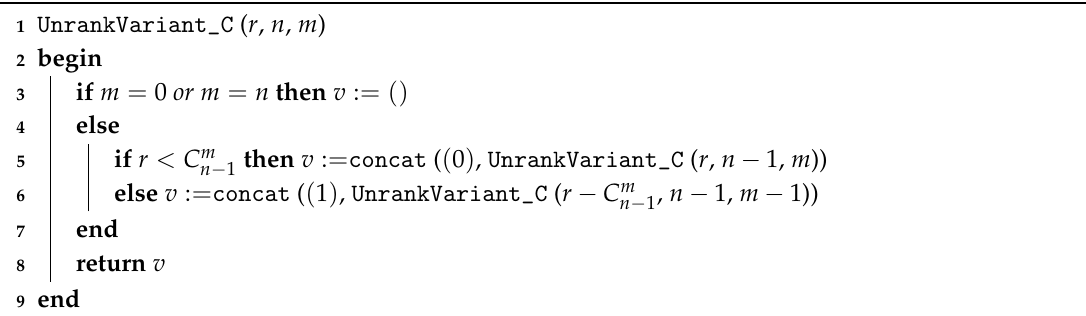
Algorithm 6: An algorithm for unranking the variants of the AND/OR tree for C m